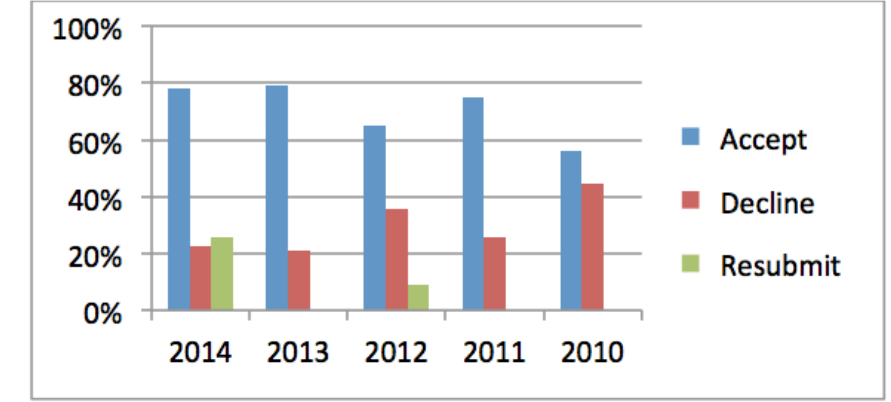
Figure 3. JOTSE’s rate of